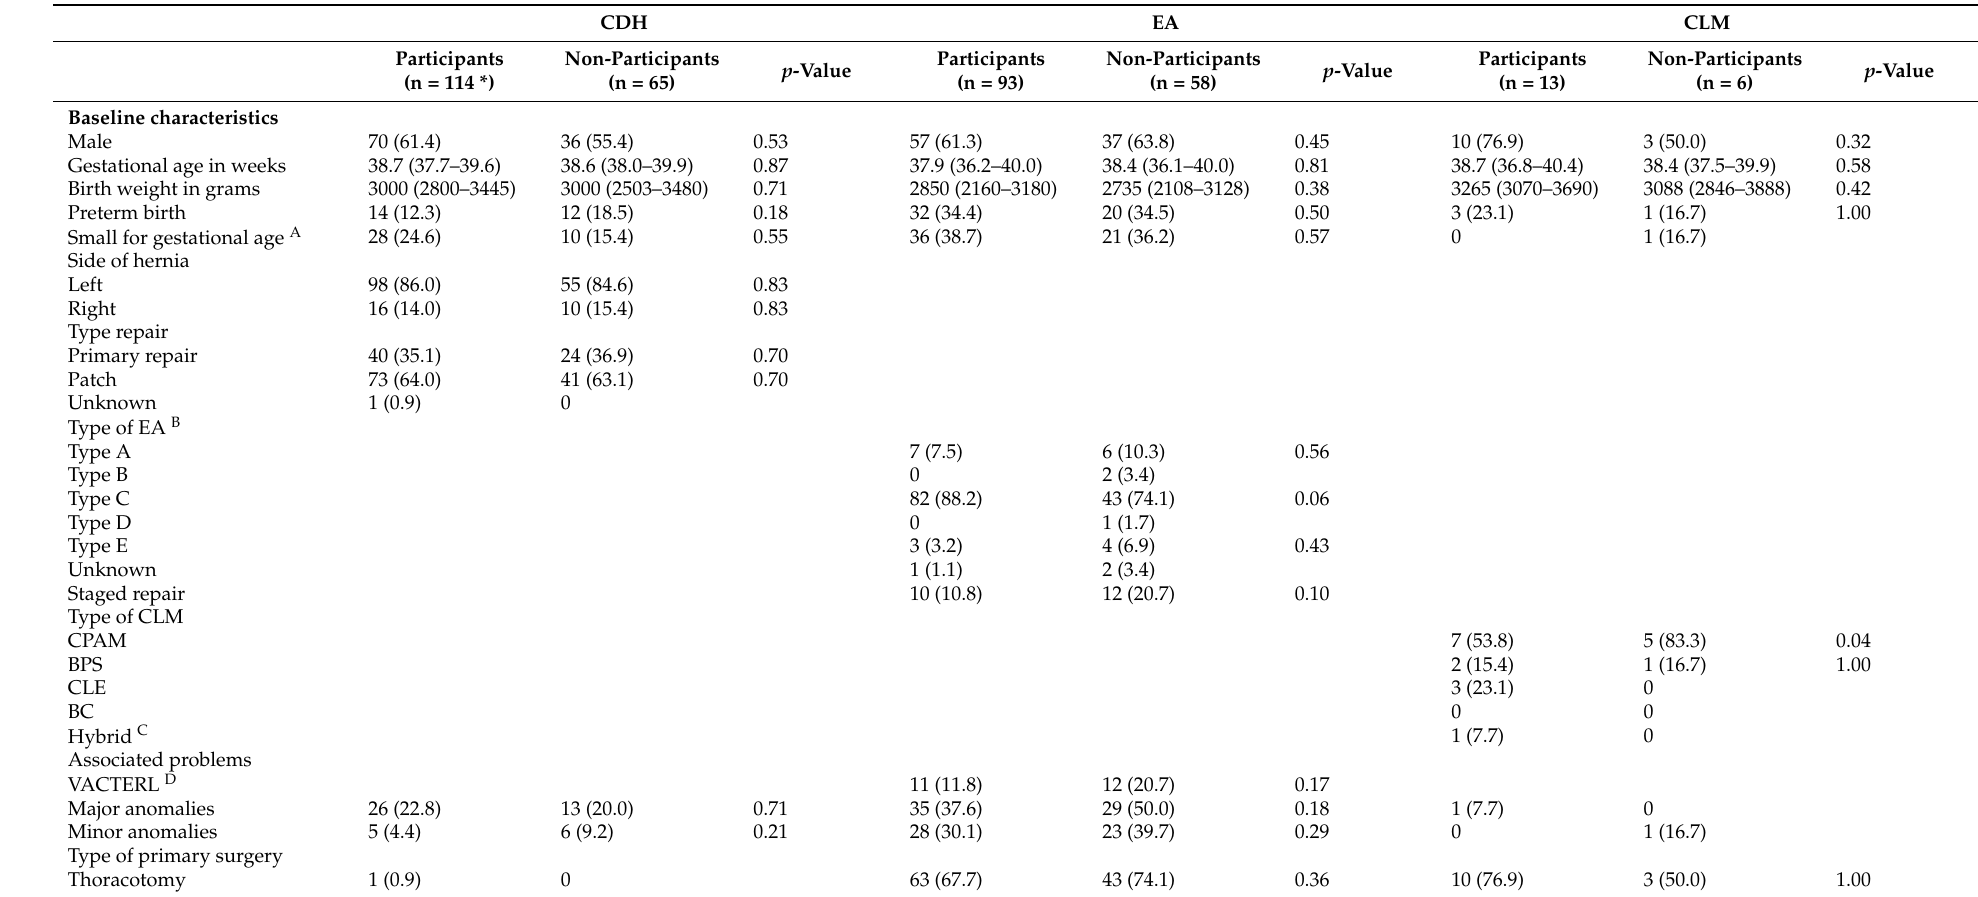
Table 1. Demographic variables of participating and non-participating children with congenital diaphragmatic hernia (CDH), esophageal atresia (EA), and congenital lung malformation (CLM). Data are presented as n (%) or median (IQR). One patient had both CDH and an incidental finding of CLM, and was included in the CDH group. CPAM = congenital pulmonary airway malformation, BPS = bronchopulmonary sequestration, CLE = congenital lobar emphysema, BC = bronchogenic cyst, VACTERL = vertebral, anorectal, cardiac, tracheoesophageal, renal, and limb malformations, ISCED = International Classification of Education [21]. Asterisk indicates significance ( p <